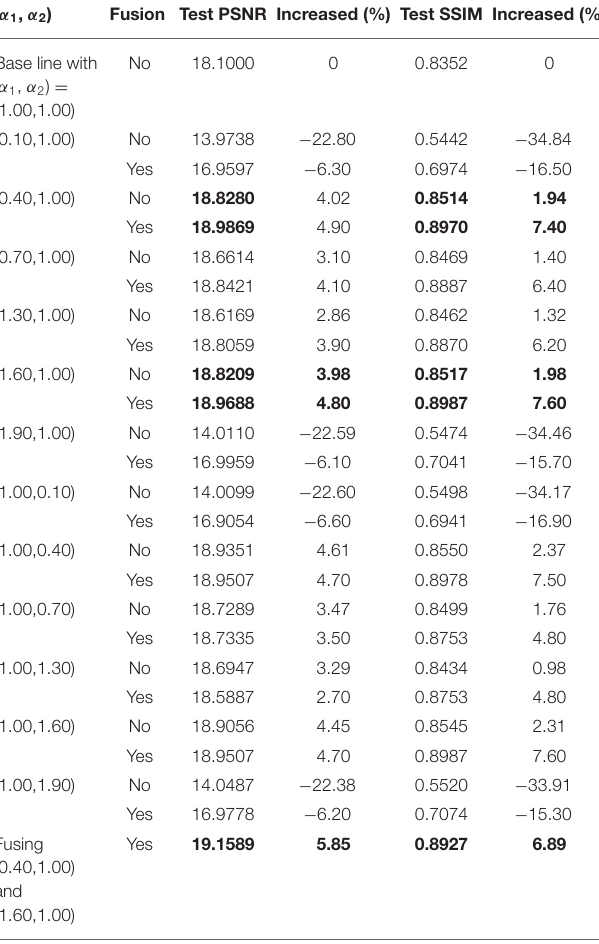
TABLE 4 | Results with FrScatNets on the CIFAR-10 dataset. ( α 1 , α 2 ) Fusion Test PSNR Increased (%) Test SSIM Increased (%)